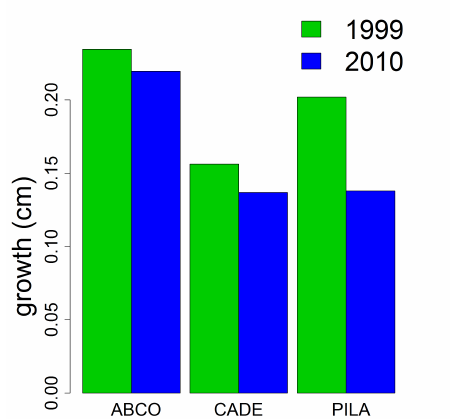
Figure A2. Example of simulated growth for three common species in YOHOPIPO during two distinct years: 1999 which was a dry year preceded by a wet year, and 2010 which was a wet year preceded by a dry year. Growth is computed using the final model and median values for diameter and